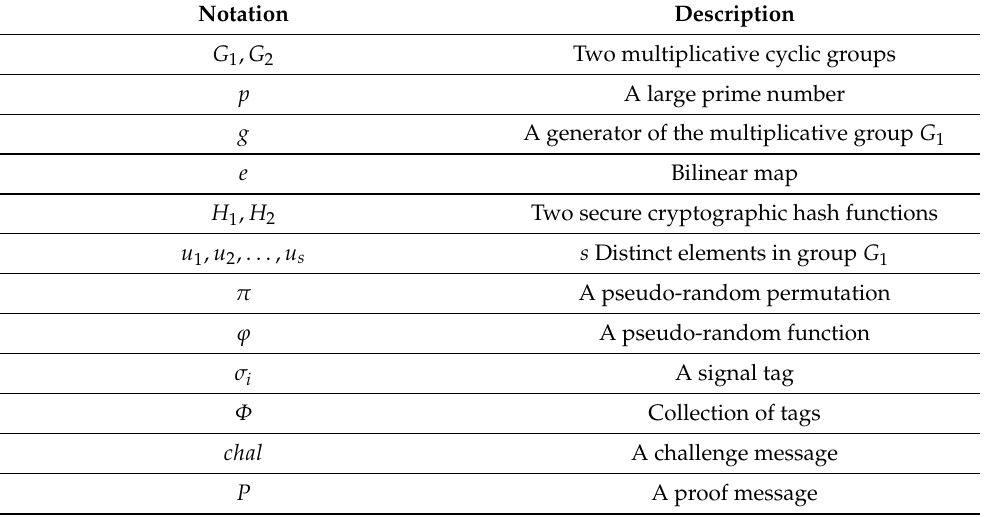
Table 1. Mathematical notations.